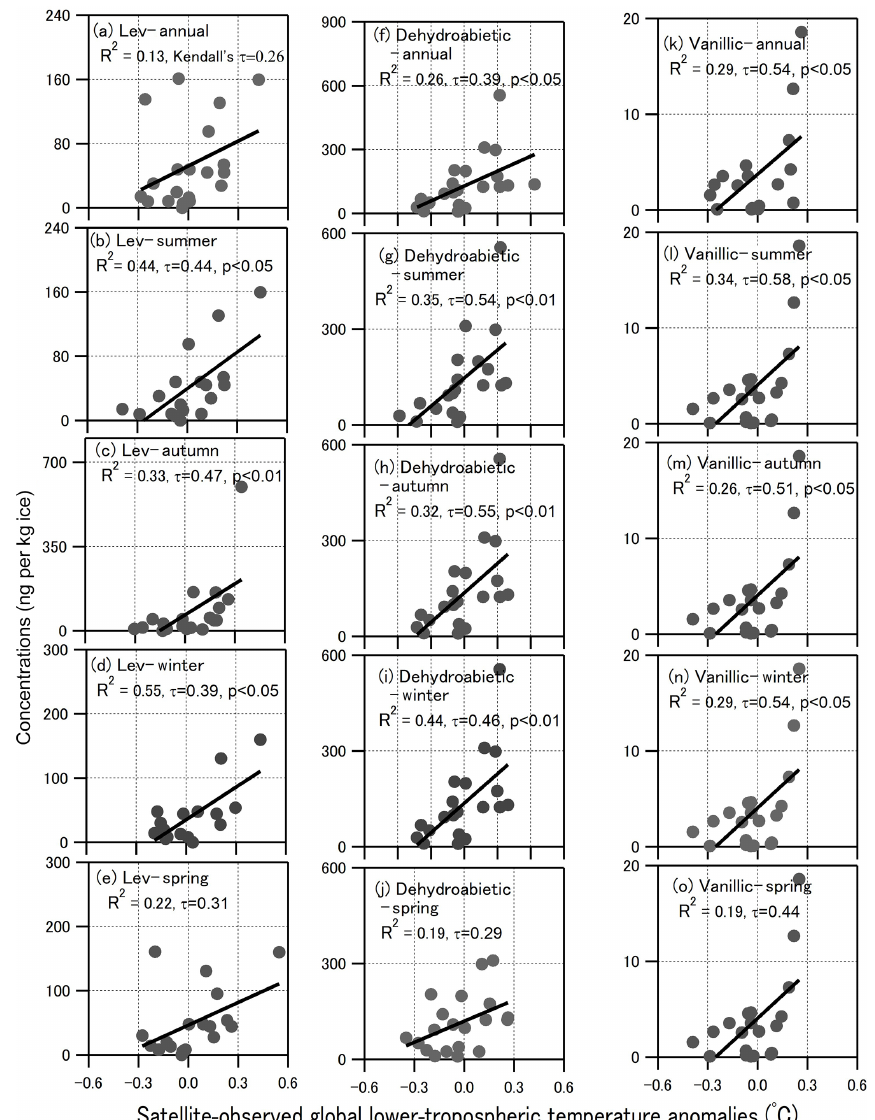
Figure 6. Correlation (Pearson: R 2 ; Kendall: τ ) plots between satellite-observed global lower-tropospheric temperature anomalies (i.e., microwave-sounding-unit temperature anomalies ( ◦ C) of annual and seasonal records) and annual concentrations of (a–e) levoglucosan, (f–j) dehydroabietic acid and (k–o) vanillic acid after the Great Pacific Climate Shift in the Northern Hemisphere